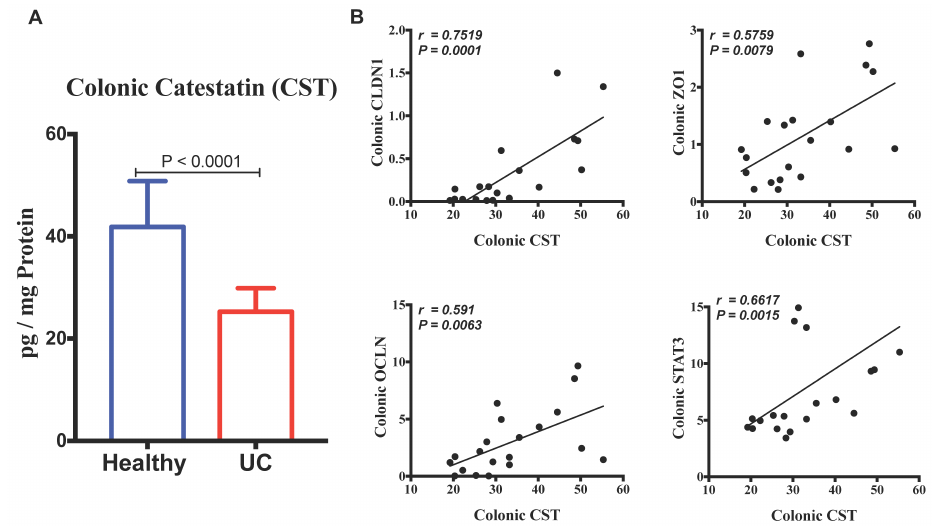
Figure 1. Colonic protein level of Catestatin (CST) has a strong positive linear relationship with mRNA gene expression of tight junction (TJ) proteins and STAT3 in samples pooled from patients with active ulcerative colitis (UC) and healthy individuals. ( A ) The expression levels of CST in patients with UC and healthy individuals; ( B ) The correlation of CST with mRNA levels of (Claudin ( CLDN1 ), zonula occludens-1 ( ZO1 ), and occludin ( OCLN ) and STAT3 ). Spearman’s correlation tests, two tailed significance level adjusted at p < 0.05, and Student- t test.